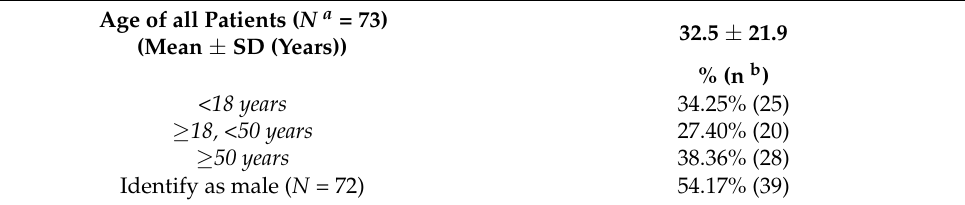
Table 2. Demographic characteristics of all included